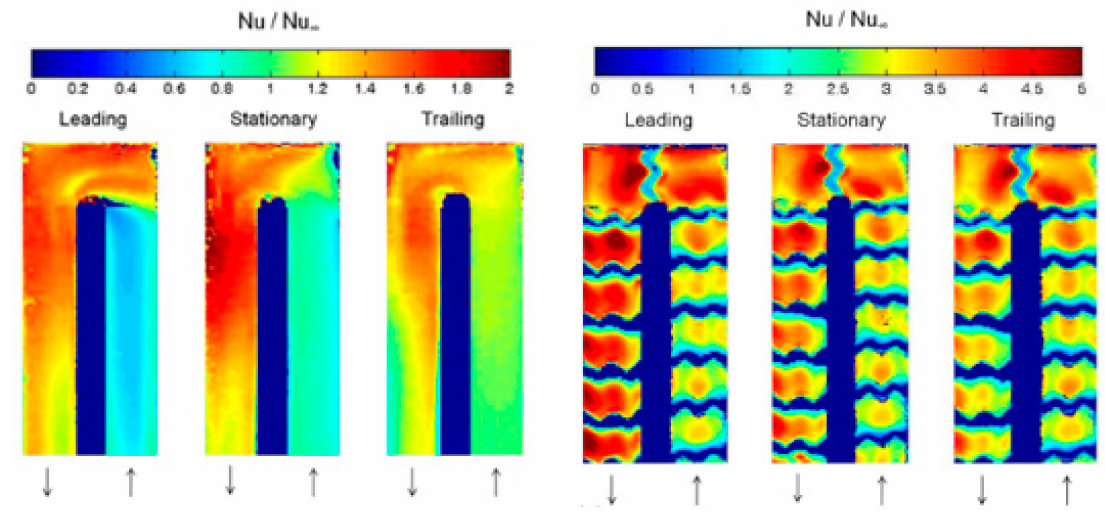
Figure 16. Detailed Nusselt number ratio ( Nu / Nu 0 ) for smooth and W-shaped ribbed channels under stationary and rotating conditions